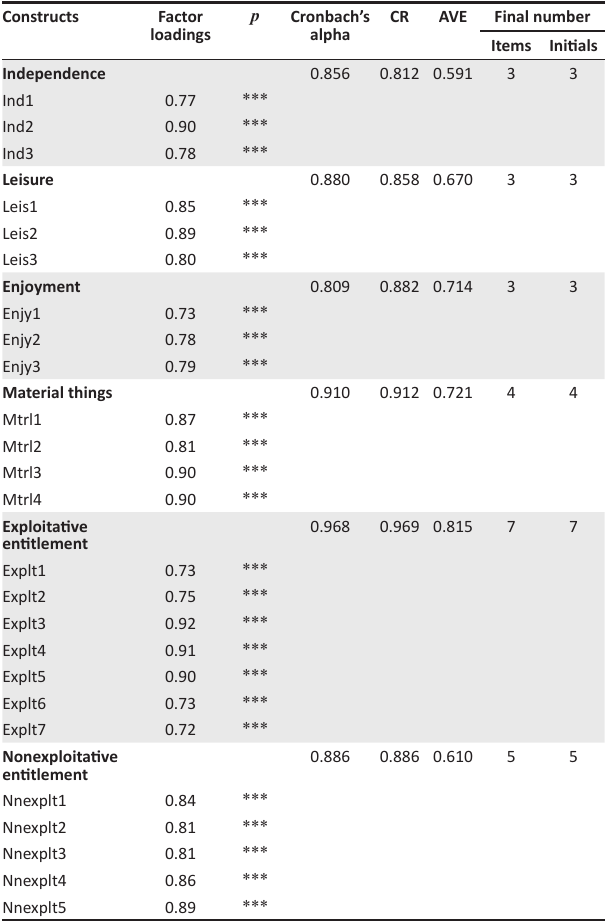
TABLE 2: Statistical evidence of reliability and convergent validity. Constructs